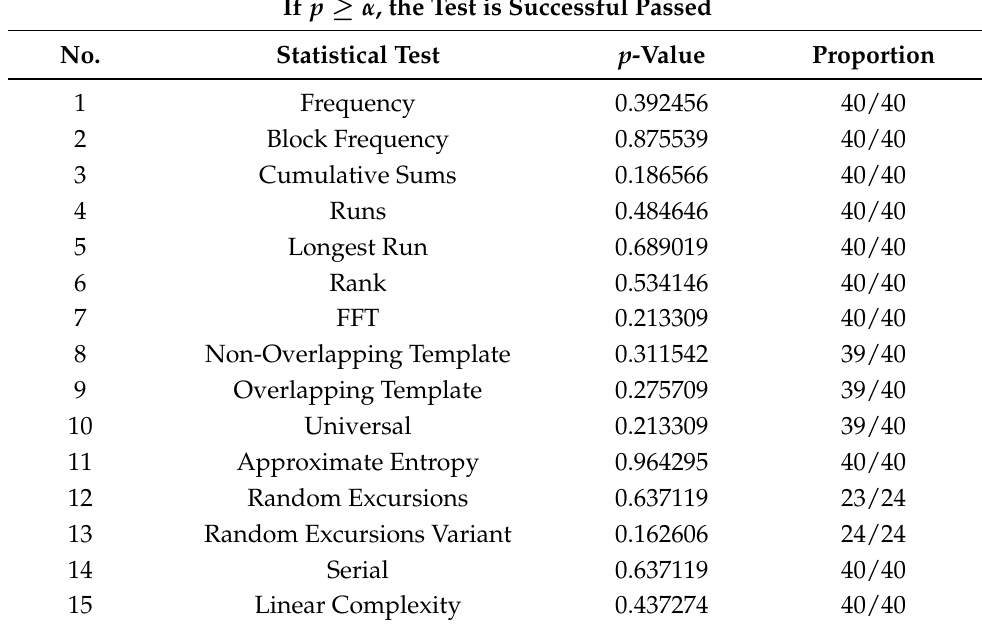
Table 3. NIST statistical test results, with a =